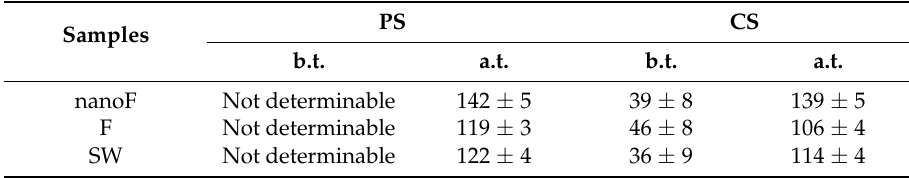
Table 6. Water–stone static contact angle ( ◦ ) measured on each stone, along with the standard deviation, before (b.t.) and after (a.t.) each